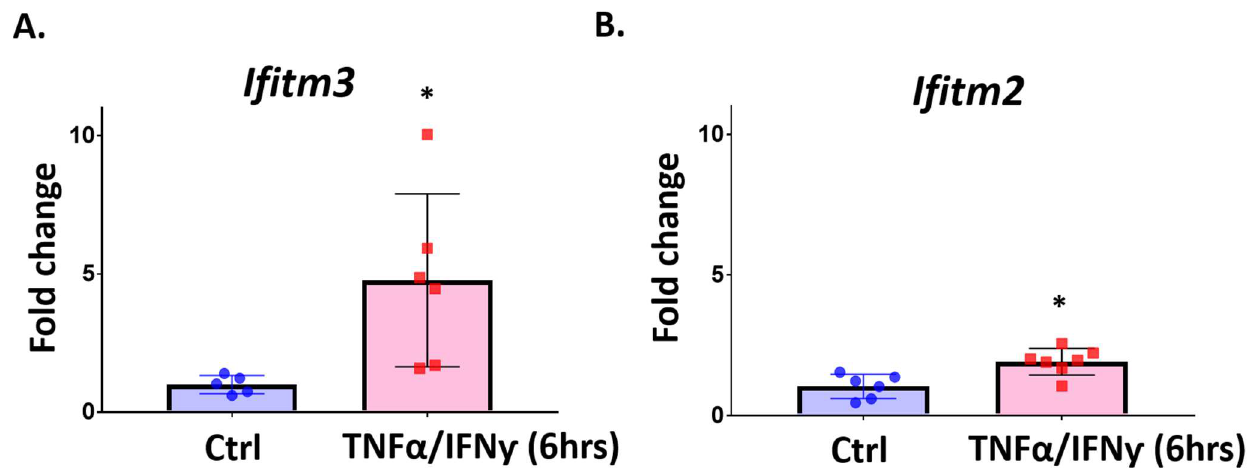
Figure 5. The expression of Ifitm3 is increased at 6 h after TNFα and IFNγ treatment in primary microglia. Primary microglia were treated with TNFα and IFNγ (20 ng/mL) for 6 h. qRT-PCR was performed to measure gene expression for Ifitm3 and Ifitm2 . ( A ) The level of Ifitm3 was increased by TNFα and IFNγ ( n = 5–6, * p < 0.05 compared to control). ( B ) The level of Ifitm2 was also increased by TNFα and IFNγ ( n = 6–7, * p < 0.05 compared to control, two-tailed unpaired Student’s t -test).